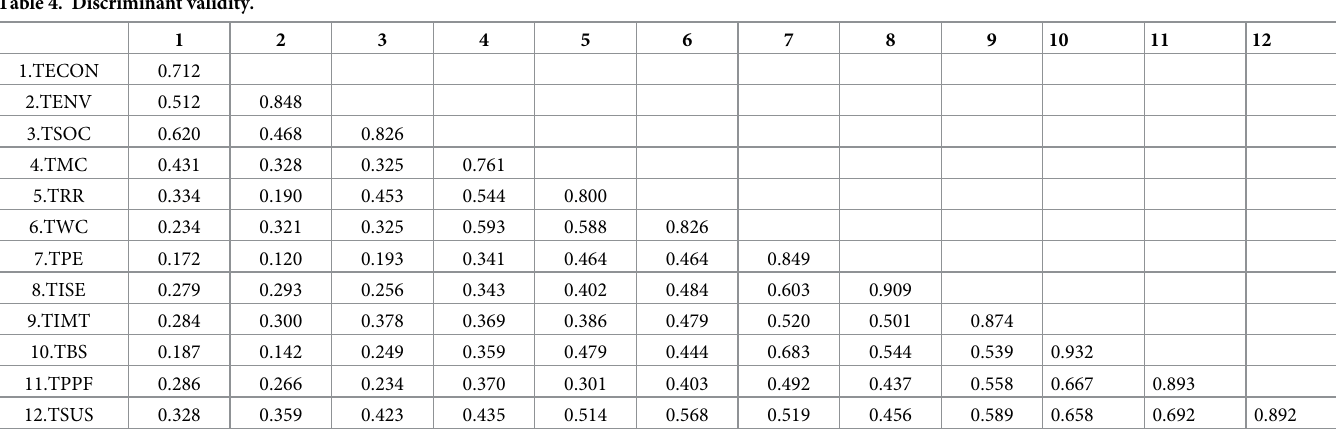
Table 4. Discriminant